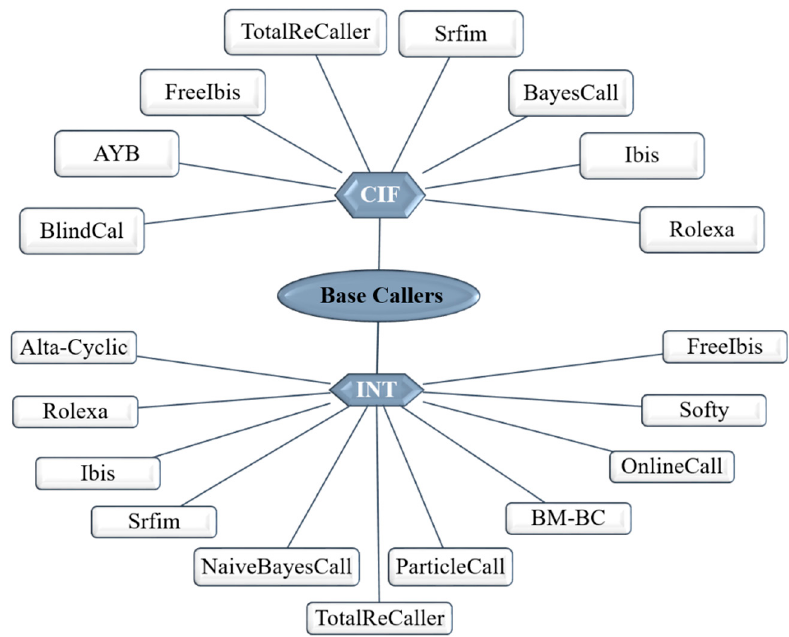
Figure 4. Summary of some widely used base callers’ software available for the Illumina platform.